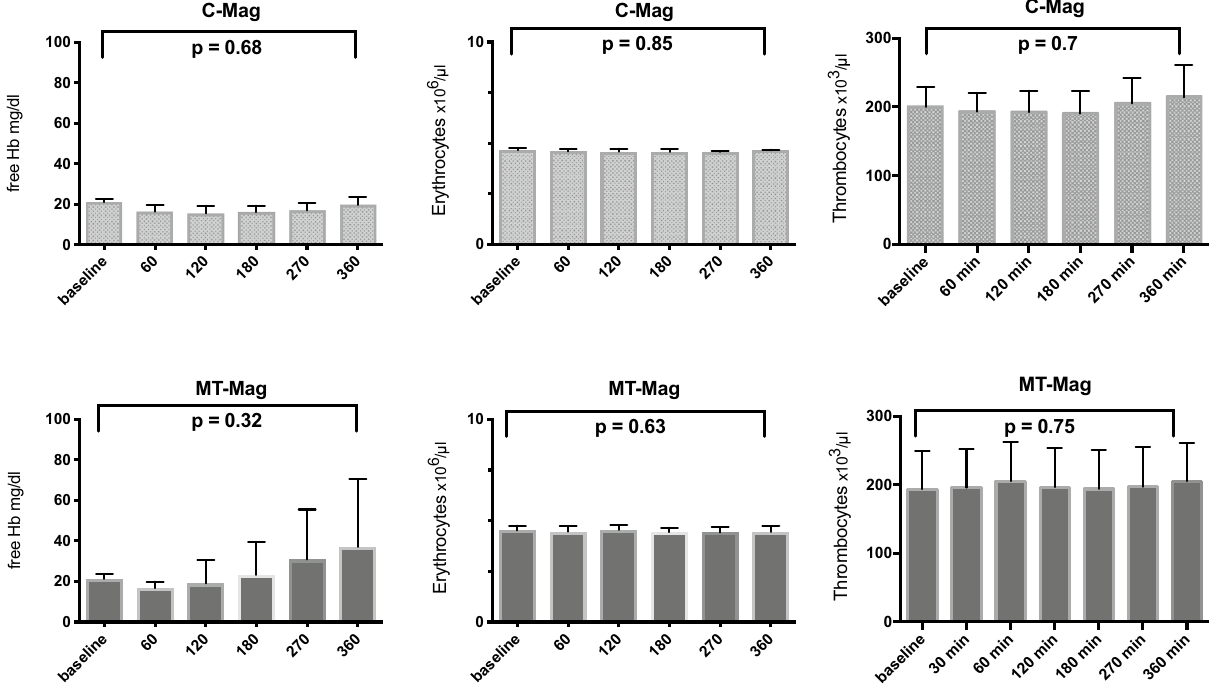
Figure 2. Plasma-free hemoglobin, as well as cell counts of erythrocytes and thrombocytes in the MT-Mag and C-Mag groups. Hemolysis and numbers of erythrocytes and thrombocytes were stable in both groups throughout the experimental